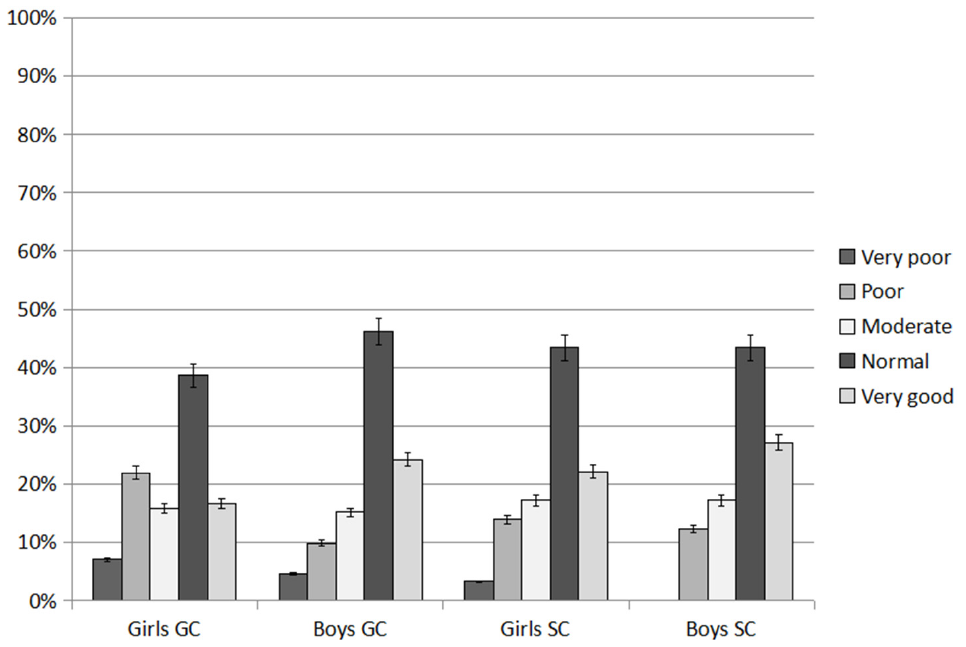
Figure 3. Results of the 10 × 5 m shuttle run test, an average over the study period. GC—general education classes; SC—sport classes.